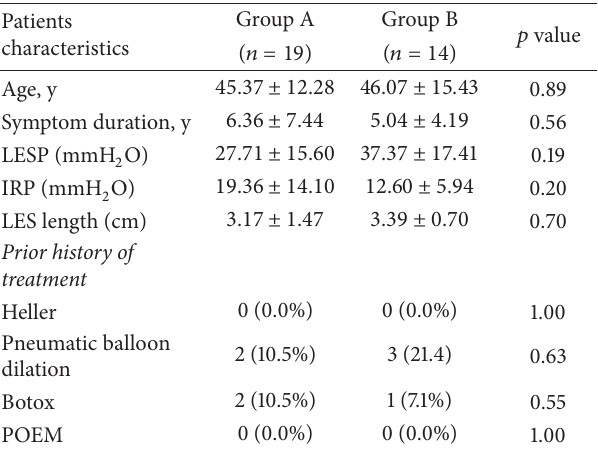
Table 1: Preoperative patients